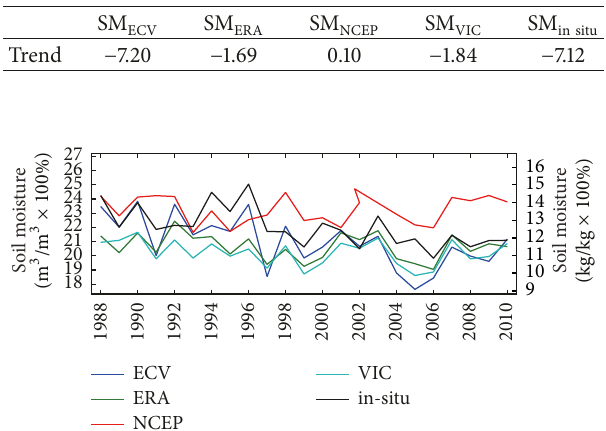
Figure 6: Interannual variations of annual soil moisture for the period of 1988–2010, which are spatially averaged in the selected study area as shown in Figure 1.